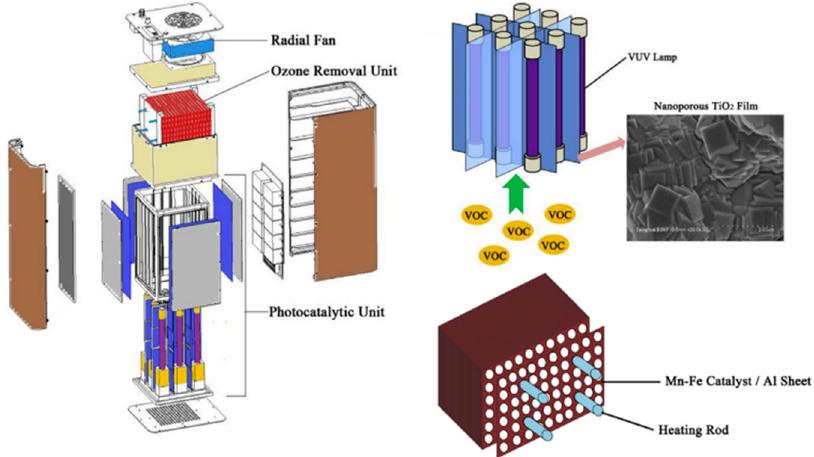
Figure 10. Schematic representation of the VUV (vacuum ultraviolet)-PCO air purifier. Reprinted from Reference [85], Copyright (2018), with permission from Elsevier.